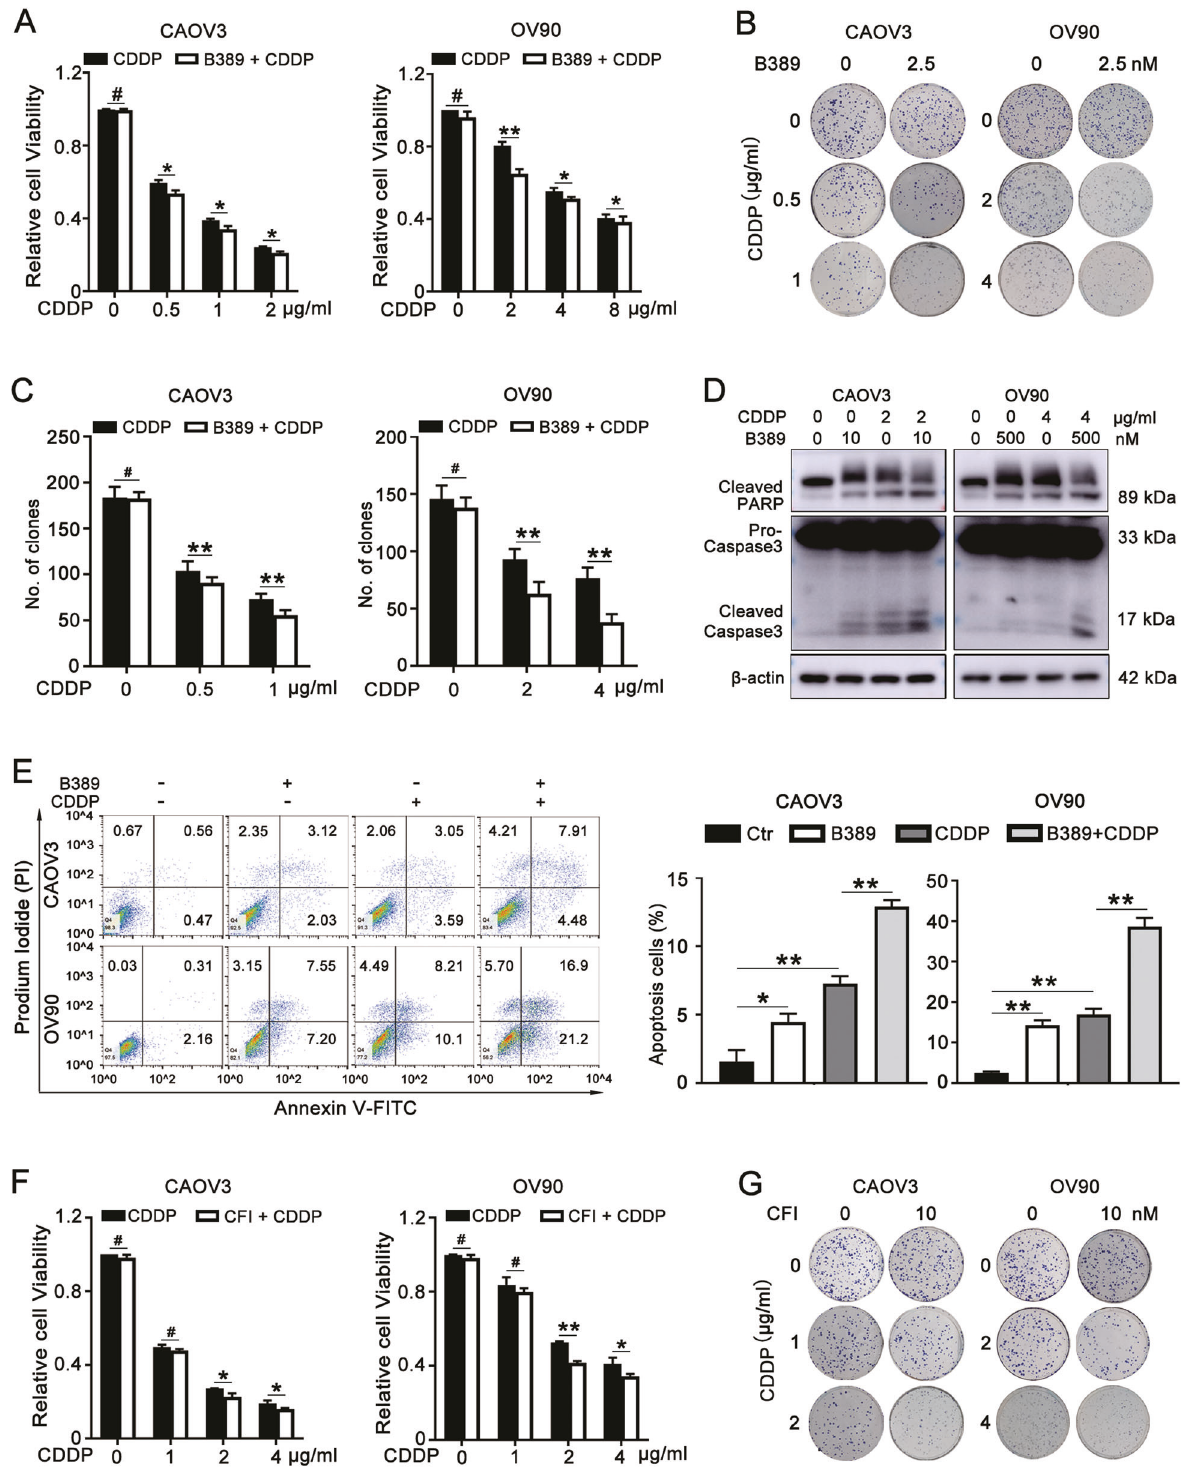
Fig. 5 TTK inhibitors render CAOV3 and OV90 cells more sensitive to cisplatin. A − C CAOV3 and OV90 cells were treated with the indicated concentrations of CDDP (0, 0.5, 1, or 2 μ g/ml for CAOV3 cells and 0, 2, 4, or 8 μ g/ml for OV90 cells) in combination with or without B389 (2.5 nM) for 48 h. A The MTT assay was conducted to determine cell viability. B , C The cotreatment ef fi ciency of B389 and CDDP was assessed using the colony formation assay. D , E CAOV3 and OV90 cells were treated with DMSO, B389 (10 nM for CAOV3 and 500 nM for OV90), or CDDP (2 μ g/ml for CAOV3 and 4 μ g/ml for OV90) alone or in combination with B389 and CDDP. D The protein levels of cleaved PARP, cleaved caspase-3, and TTK were evaluated using western blotting. β -actin served as an endogenous control. E Apoptotic cells in different groups were detected using fl ow cytometry. F , G The MTT assay ( F ) and colony formation assay ( G ) were evaluated after treatment with 0, 1, 2, 4 μ g/ml cisplatin and/or 10 nM CFI (data are mean ± SEM, # P > 0.05, * P < 0.05, ** P < 0.01, n = 3).